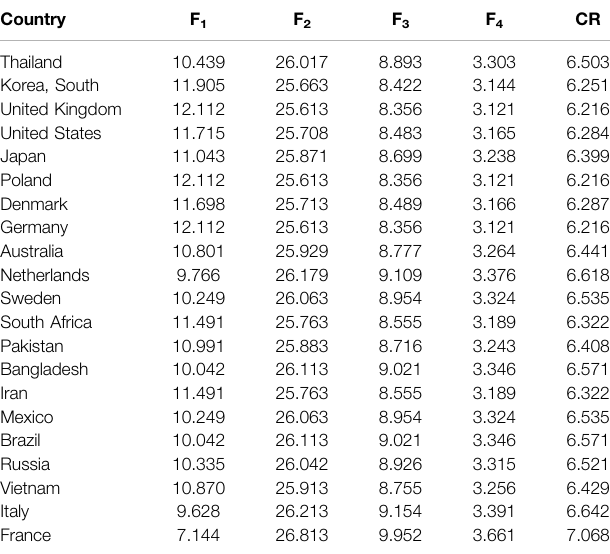
TABLE 5 | Some comprehensive score results of national risk in